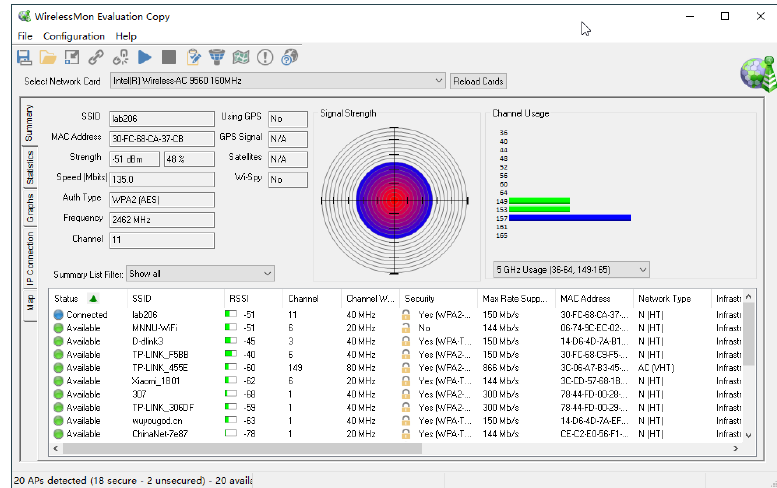
Figure 4. The signal acquisition interface.